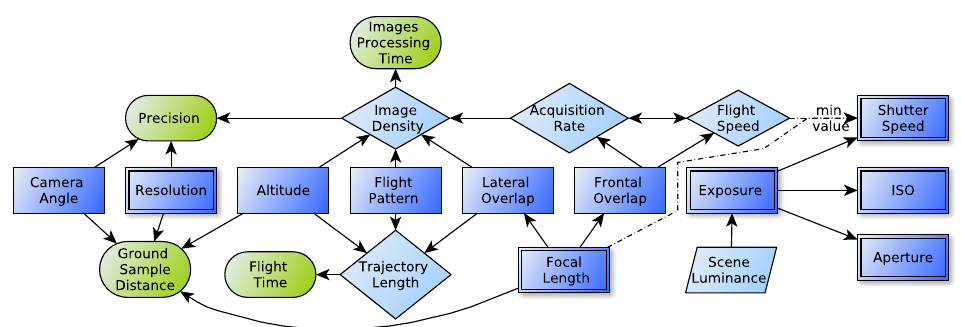
Figure 4. This simplified scheme shows the relations between the settable (rectangles) and the control (rounded nodes) parameters for the aerial photogrammetry in forests. Square nodes de- note user settable parameters (simple rectangles represent flight-related parameters while double border rectangles correspond to sensor related parameter), round nodes denote evaluation metrics, rhombuses denote inferred parameters, and slanted rectangles denote non-controllable parameters. The continuous arrows denote that the node affects the final value, while the dash arrows represent a minor